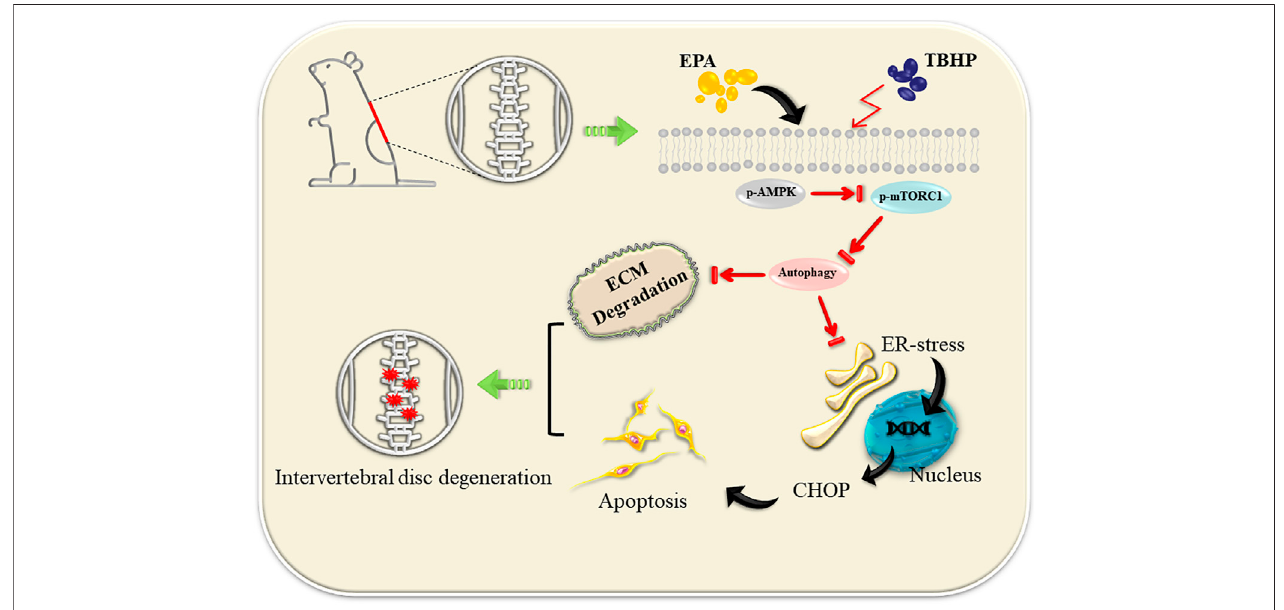
FIGURE 8 | EPA promote autophagy by activating the AMPK signalling pathway, thereby repairing ER stress and inhibiting apoptosis. At the same time, ECM degradation is alleviated.